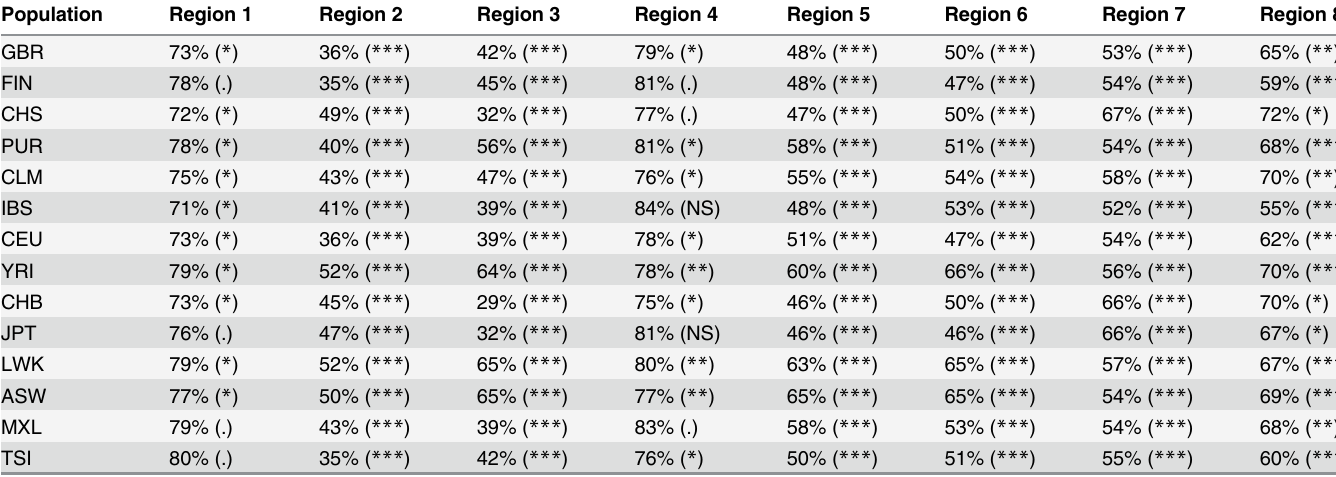
Table 2. Nucleotide diversity (measured in 100 kb non-overlapping windows) in low-ILS regions in Human populations relative to the X chromo- some average outside the low-ILS regions. Population Region 1